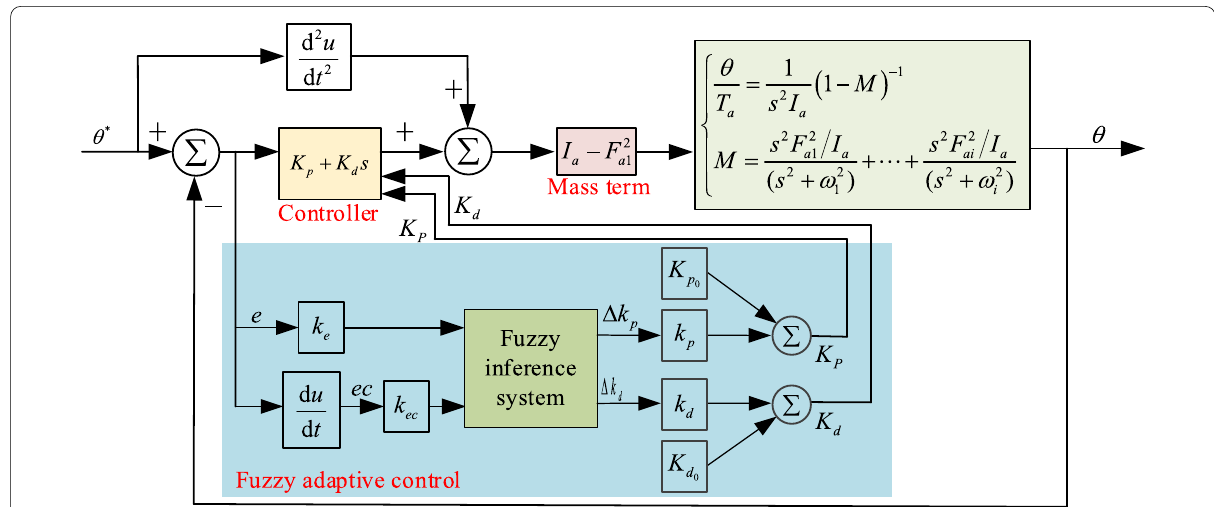
Figure 6 Control block diagram of the flexible manipulator servo system based on fuzzy adaptive